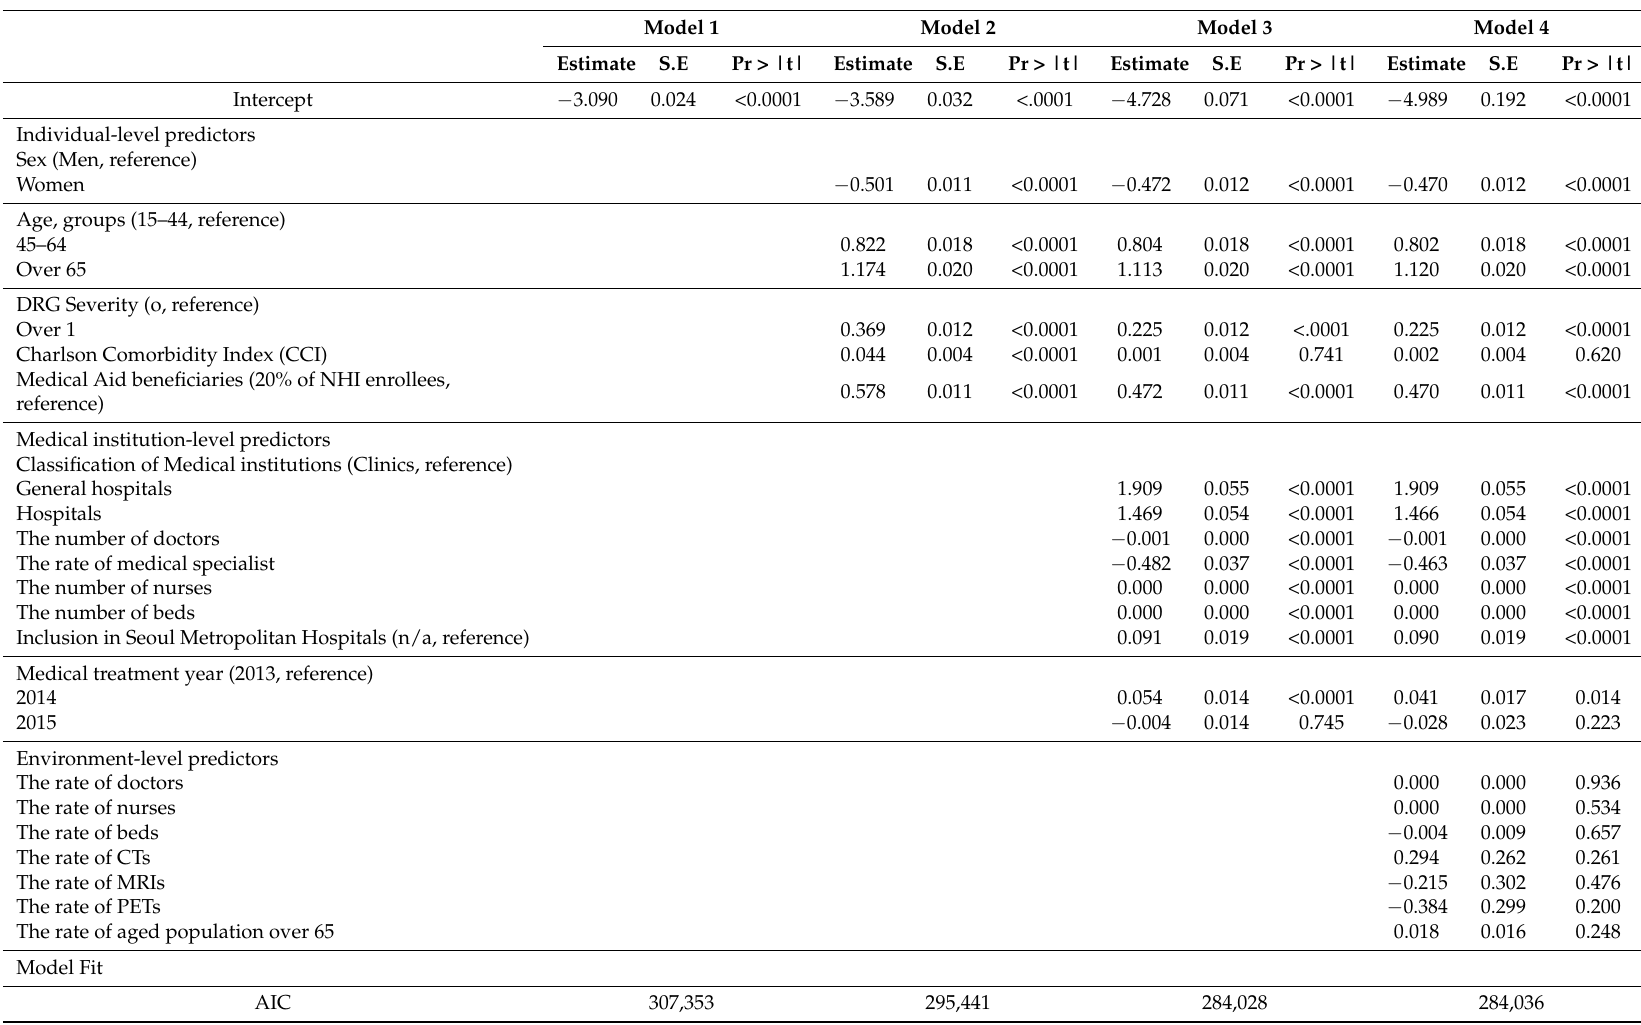
Table 3. Multilevel analysis results—preventable